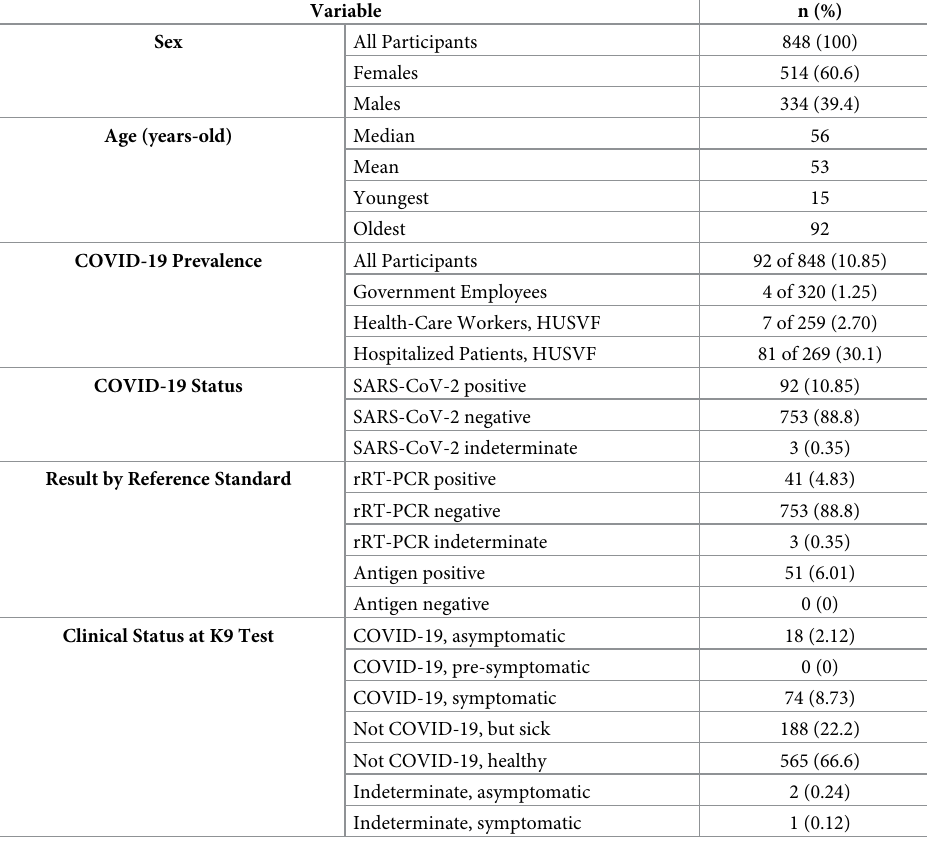
Table 2. Phase 3: In vivo screening, efficacy trial. Demographic and clinical characteristics of 848 participants in the scent-detection experiments.